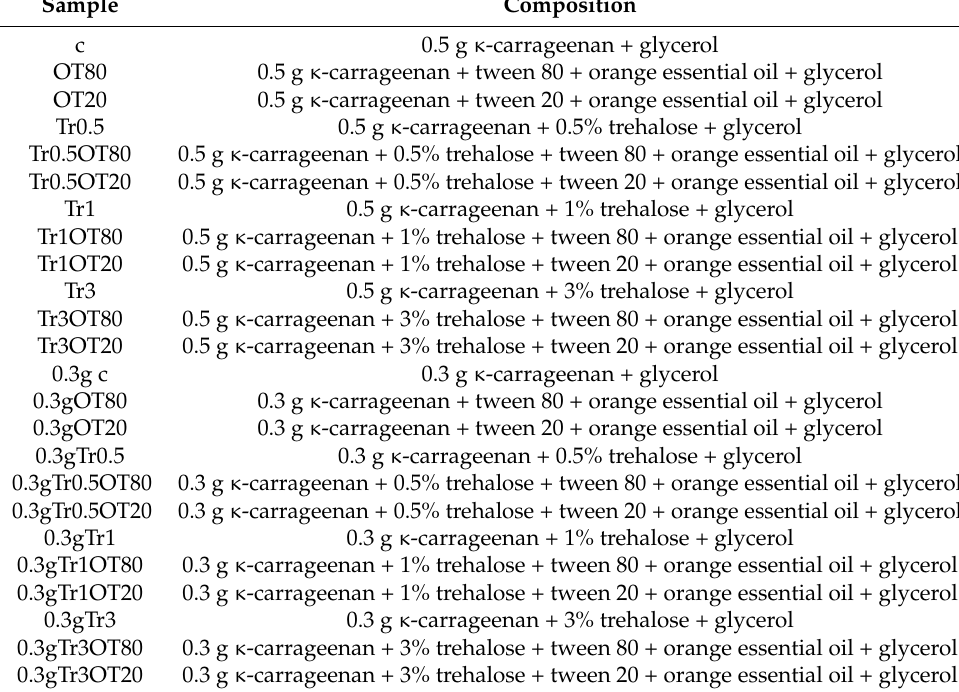
Table 1. Composition of film